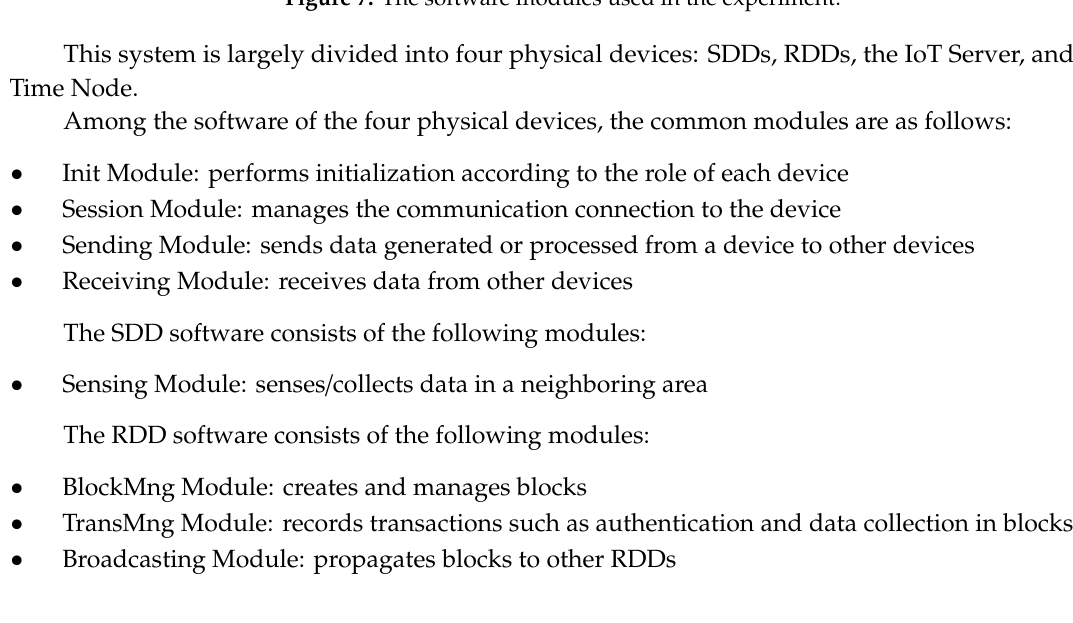
Figure 7. The software modules used in the